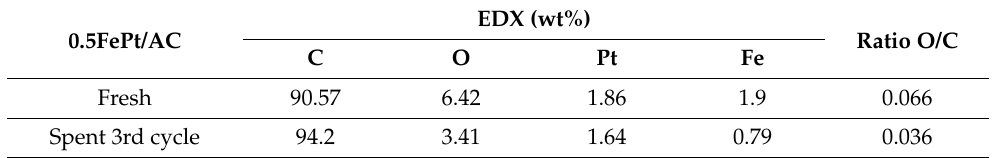
Figure 7. Catalyst recyclability with the 0.5FePt/AC catalysts for the conversion of furfural to furfuryl alcohol. Table 4. EDX results of fresh and spent 0.5 FePt/AC catalysts after 3rd